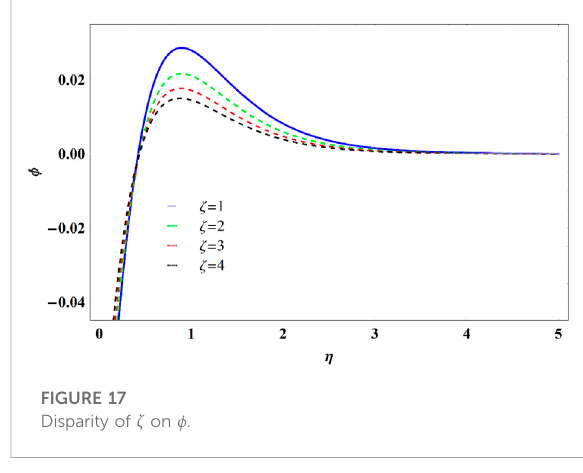
FIGURE 17 Disparity of ζ on ϕ .